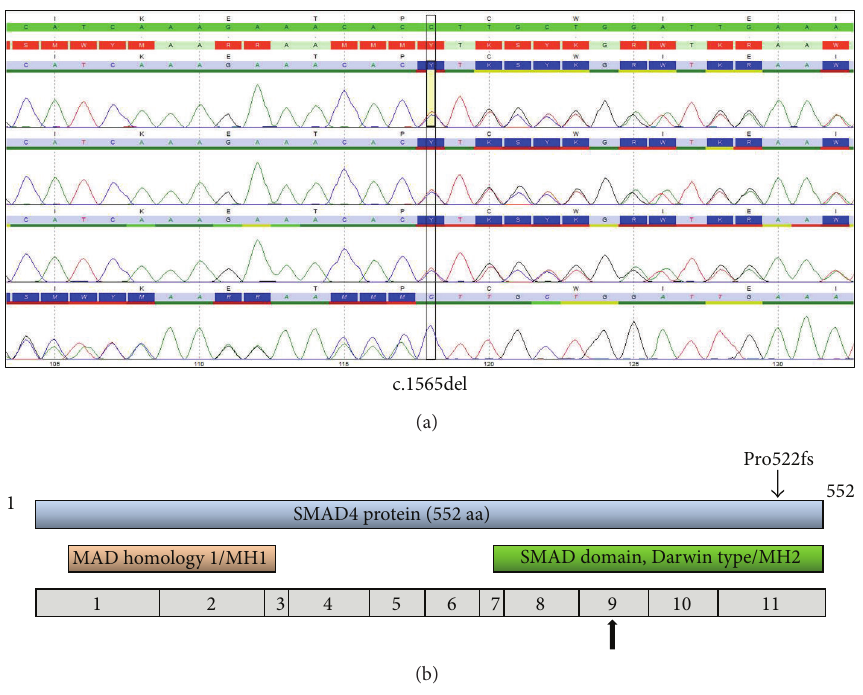
Figure 1: (a) Electropherogram of the mutation in SMAD4 . (b) The SMAD protein and its domains. The novel mutation is indicated. At the bottom of the figure, the 11 exons in relation to the protein are shown. Early described mutational hot spot in exon 9 is marked out